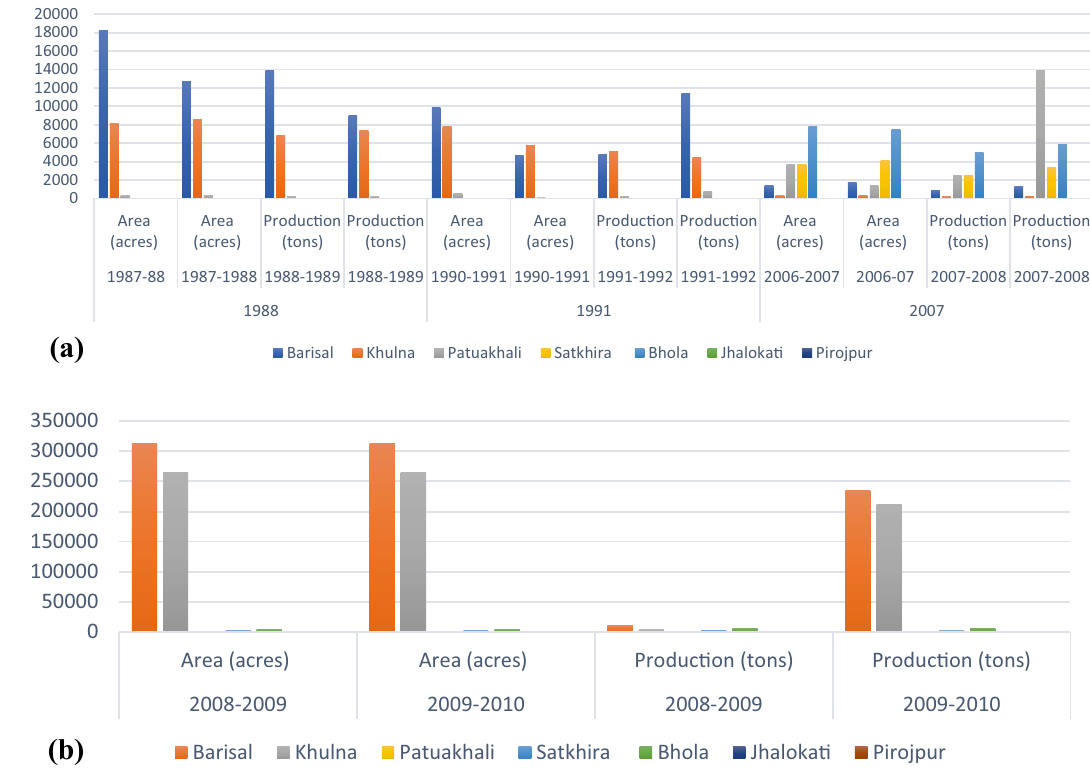
Fig. 8 a Production and area variance of wheat for years 1988, 1991, 2007; b production and area variance of wheat for years 2009. Source: “45 years Agriculture Statistics of Major Crops”